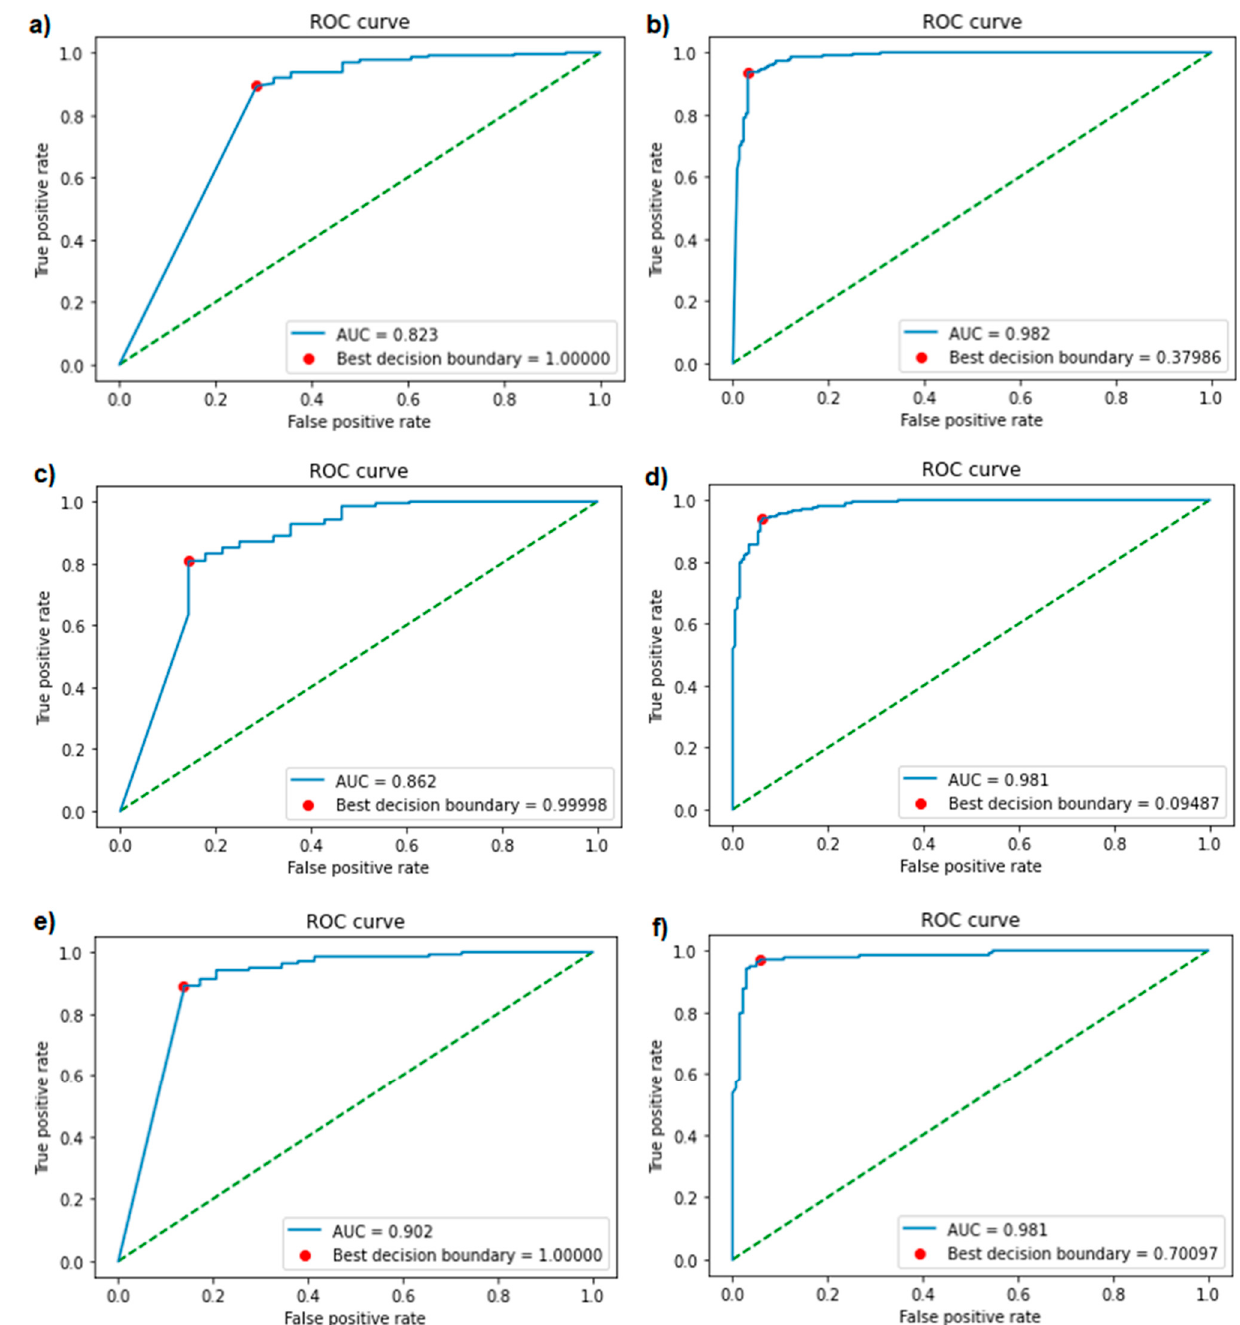
Figure 3. Receiver operating characteristic (ROC) curves and areas under the curve (AUCs) of each version of the classification model. The best threshold is represented by a red dot. The left three figures ( a , c , e ) are from the models trained with negatives from antimicrobial peptide (AMP) databases (model Version 1–3), the right three ( b , d , f ) with negatives from UniProt (model Version 4–6). From top to bottom, the models were trained with a minimal inhibitory concentration (MIC) cut-off of 100 ( a , b ), 50 ( c , d ), and 10 µM ( e , f ). The green diagonal line represents the no-discrimination line, where the model is of no use, and the false positive rate is equal to the true positive rate.